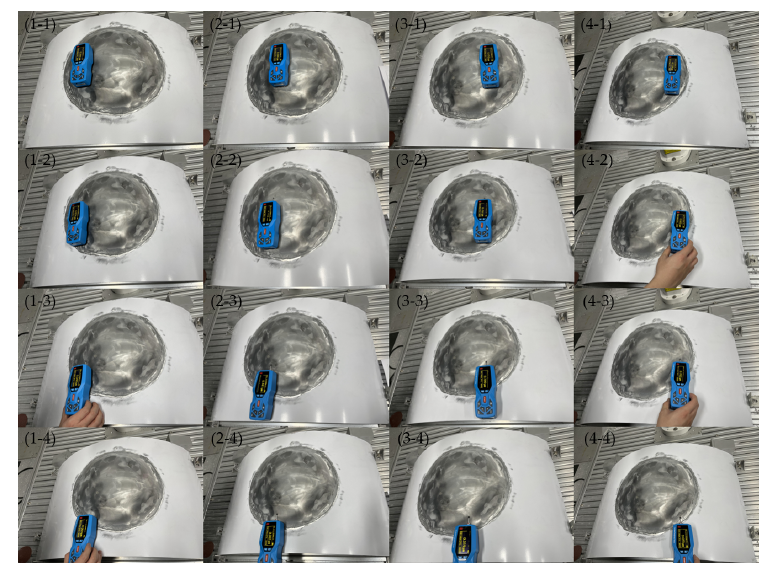
Figure 27. Roughness measurement after grinding.